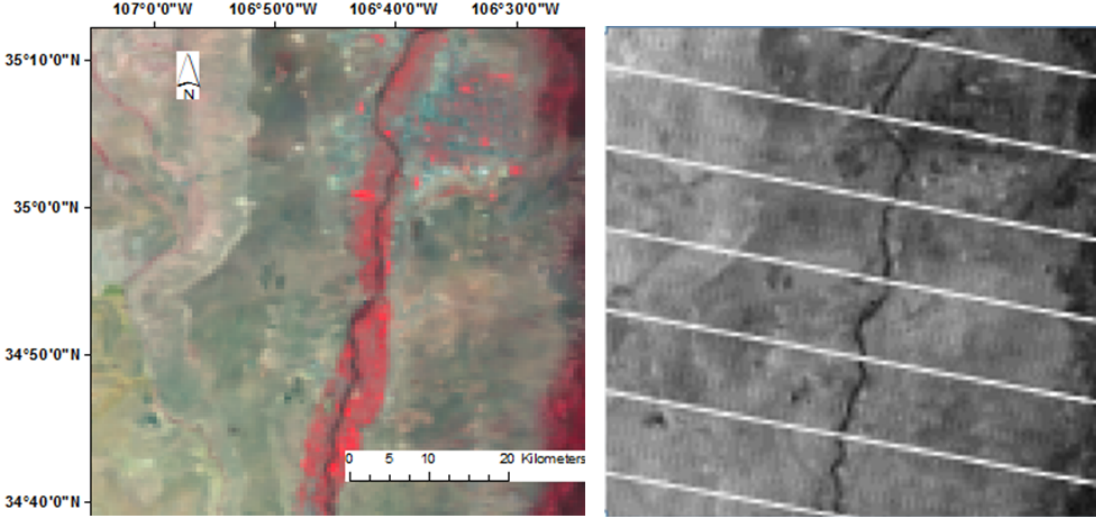
Figure 1. (Left ) MODIS-Terra image (combination 2,1,4) for 05/29/2007 near Albuquerque, NM. ( Right ) MODIS band 5 corresponding to the same image showing